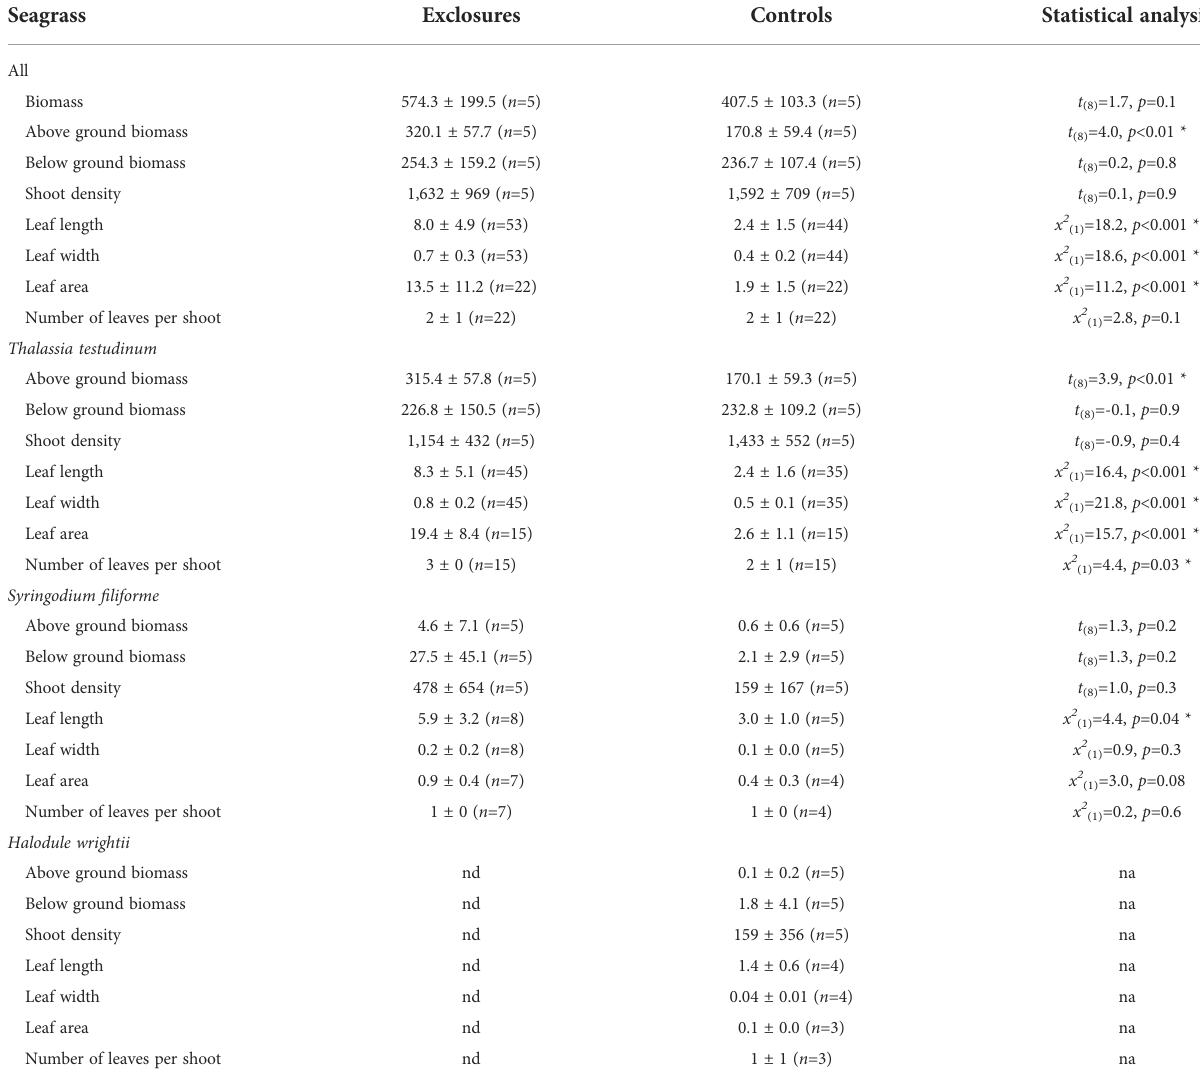
TABLE 1 Seagrass biomass (g DW m -2 ), density (shoots m -2 ), leaf length and width (cm) and area (cm 2 ), and number of leaves per shoot within exclosures and control plots following 13 months of megaherbivore exclusion at Cahuita National Park, Costa